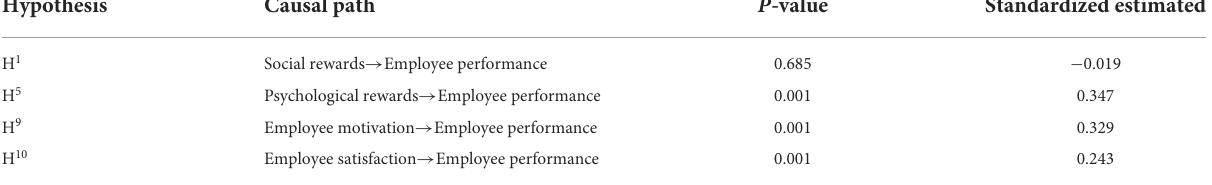
TABLE 6 Results of structural model: direct